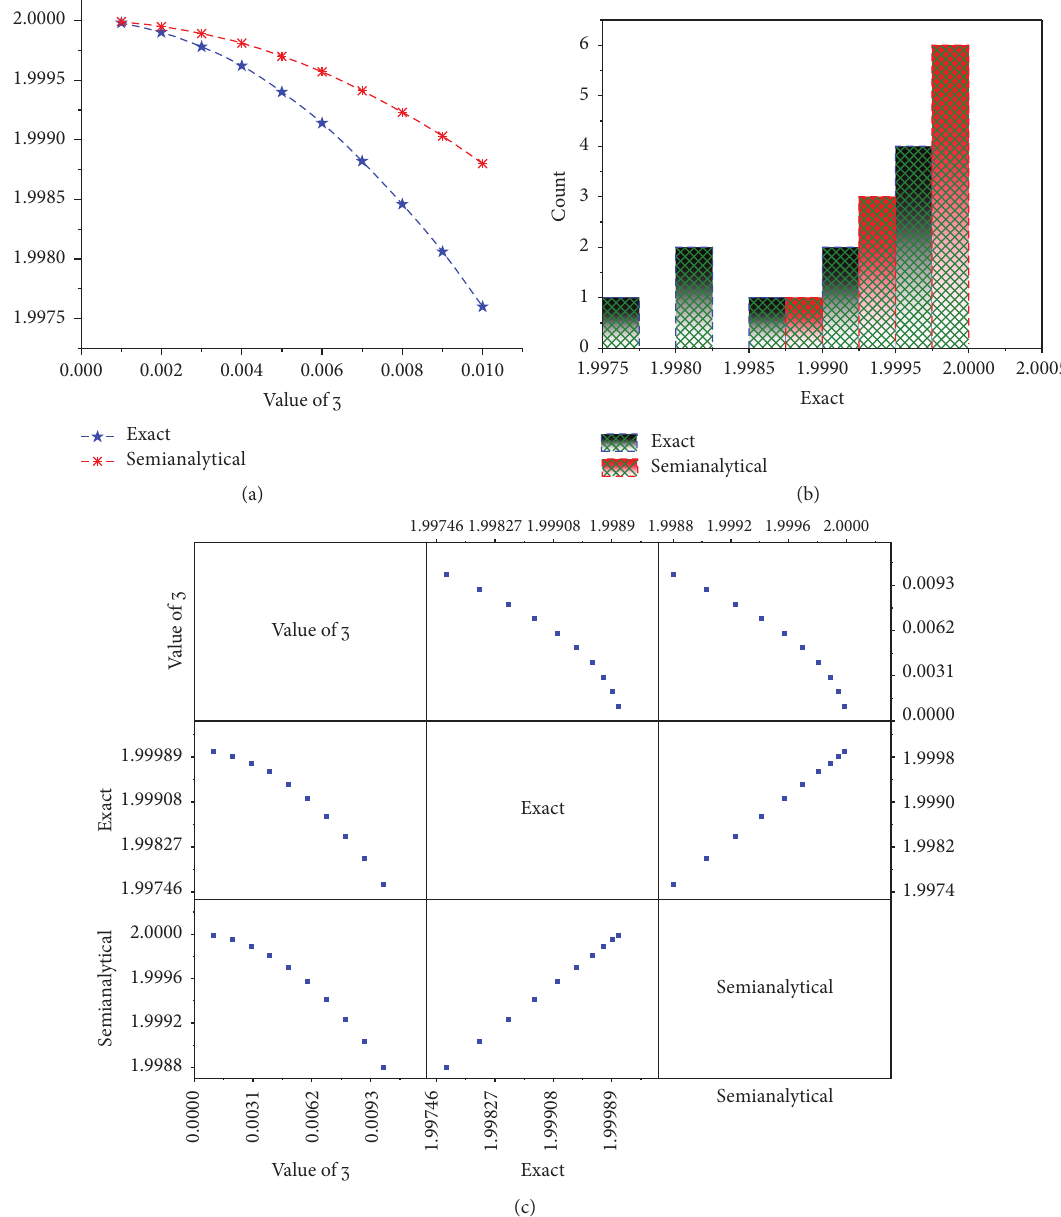
Figure 3: Exact and numerical solutions of equation (10) according to the obtained analytical solution via the extended simplest equation